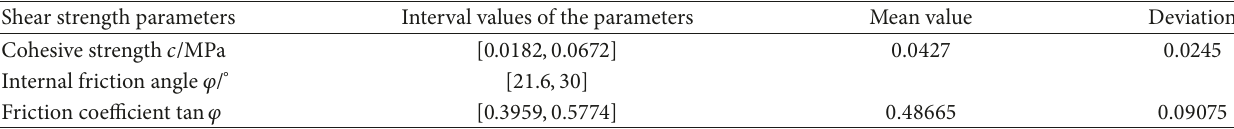
Table 2: The interval values of the shear strength